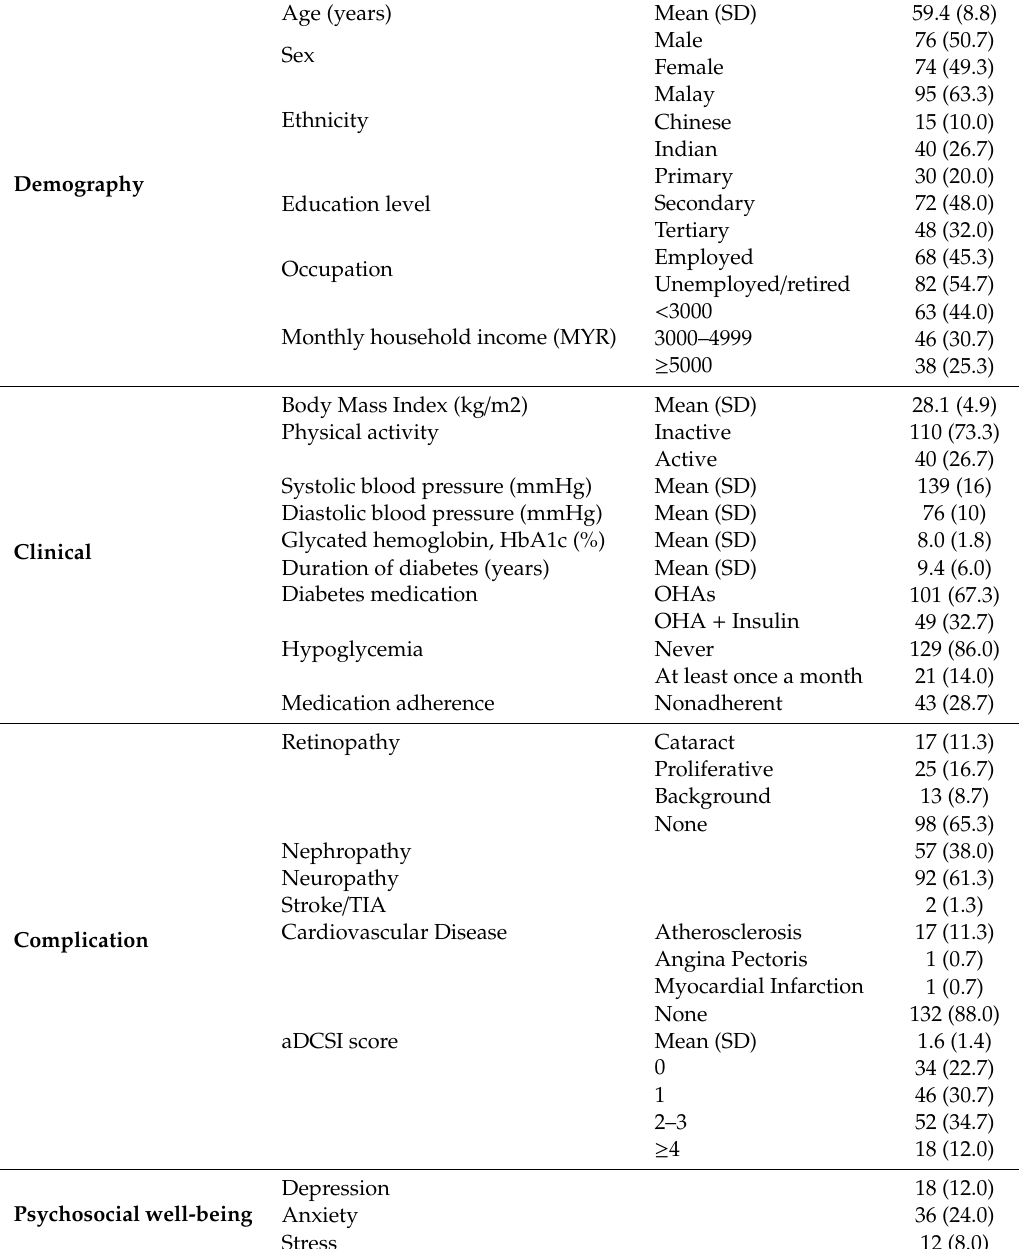
Table 1. Characteristics of the study participants (n =